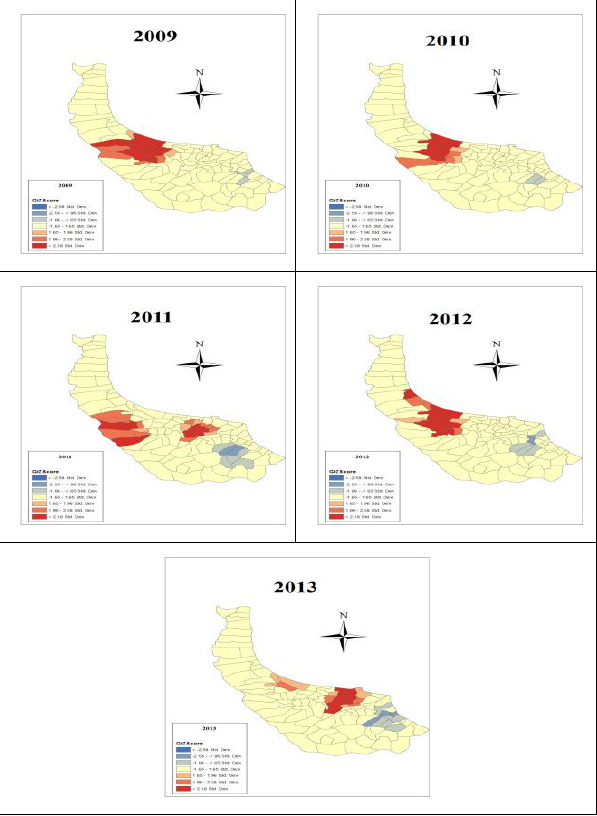
Figure 7. Getis clustering in Guilan province